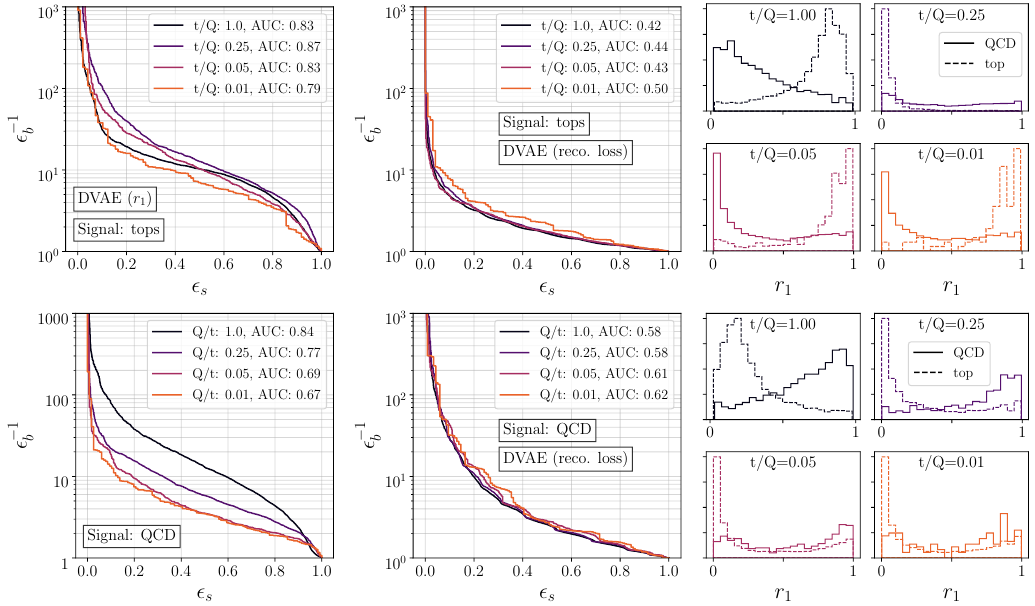
Figure 15: DVAE results using the Lund plane for various amounts of top (upper) and QCD (lower) jets in the sample, where the mixture weights (left) and the recon- struction loss (middle) of each jet are used for classification. In the small panels we show the distributions of the top and QCD jets in the latent space. the pixels by k or another Lund observable, (ii) cut off non-perturbative regions of the Lund T plane during the pre-processing. We did perform some tests with the pixel weights but the results did not show an improvement, alternatives were not fully explored in this